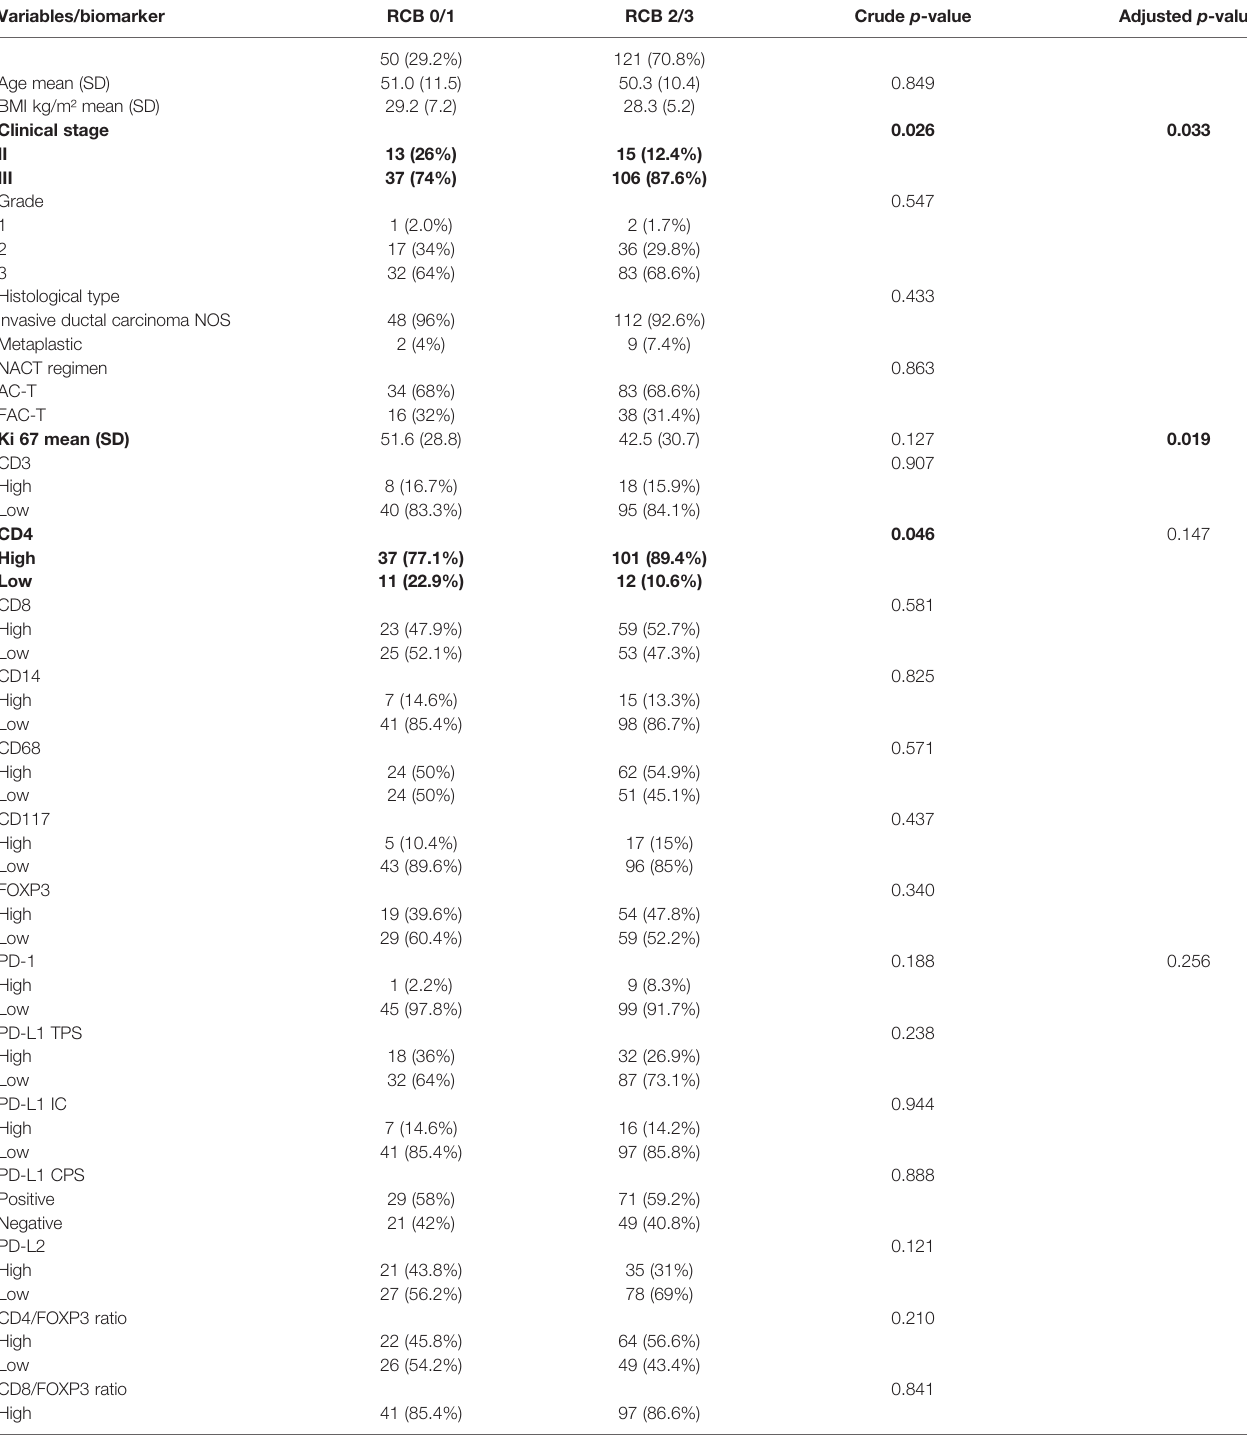
TABLE 1 | Correlation of clinical – pathological characteristics and expression pro fi le of biomarkers with residual burden cancer by logistic regression through univariate analysis ( n = 171).